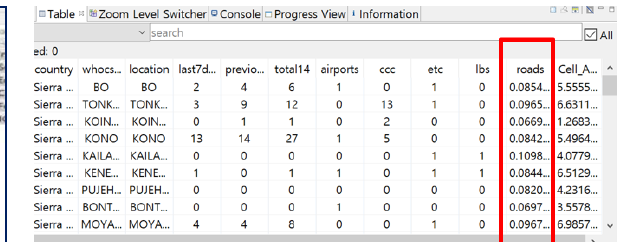
Figure 11. Result of Zonal Statistics : districts with road density